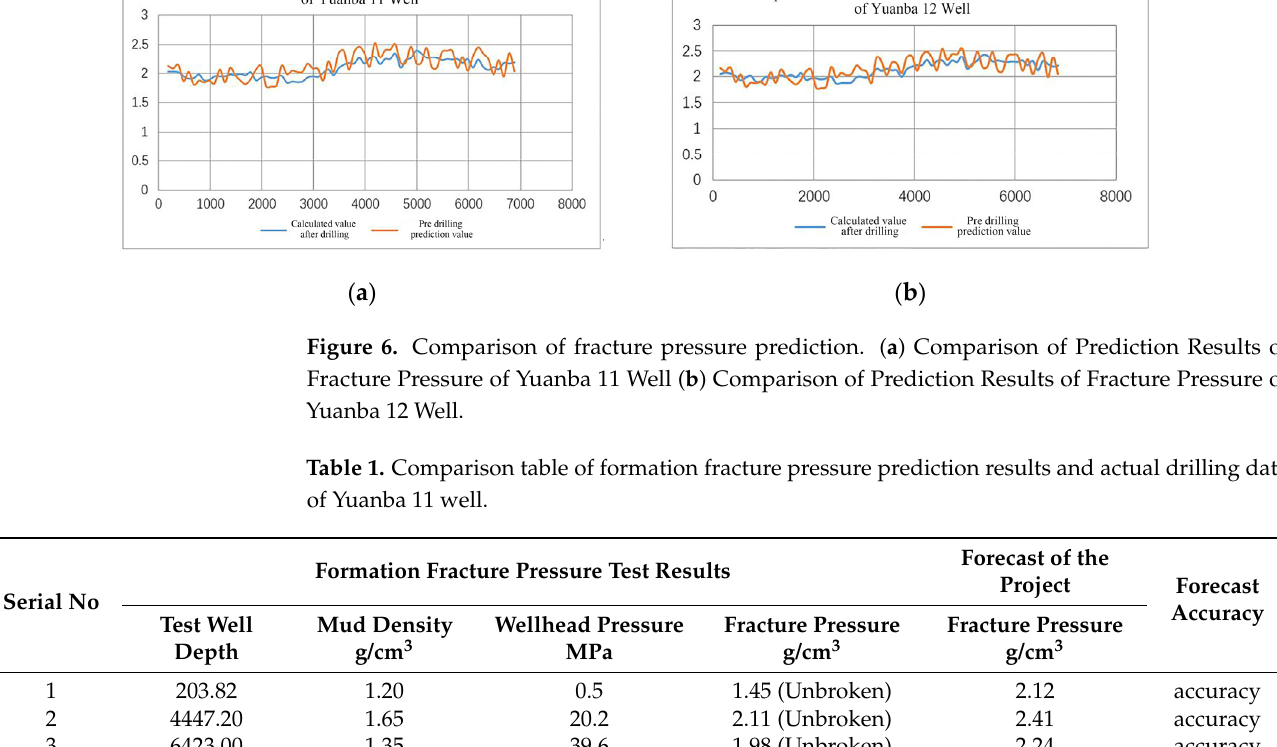
Table 1. Comparison table of formation fracture pressure prediction results and actual drilling data of Yuanba 11 well.